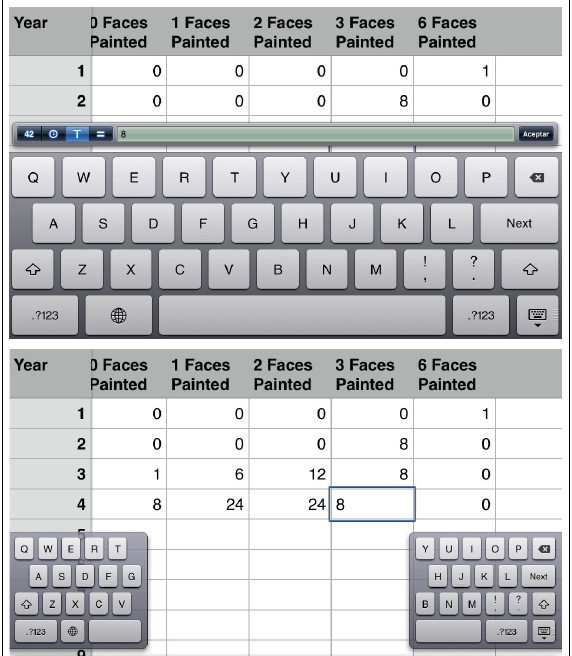
Figure 4. The keyboard of the iPad may cover a big part of the screen, making it difficult to see the part that is being typed (figure on top). However, the keyboard can be split and reduced avoiding to cover a big part of the screen (figure on